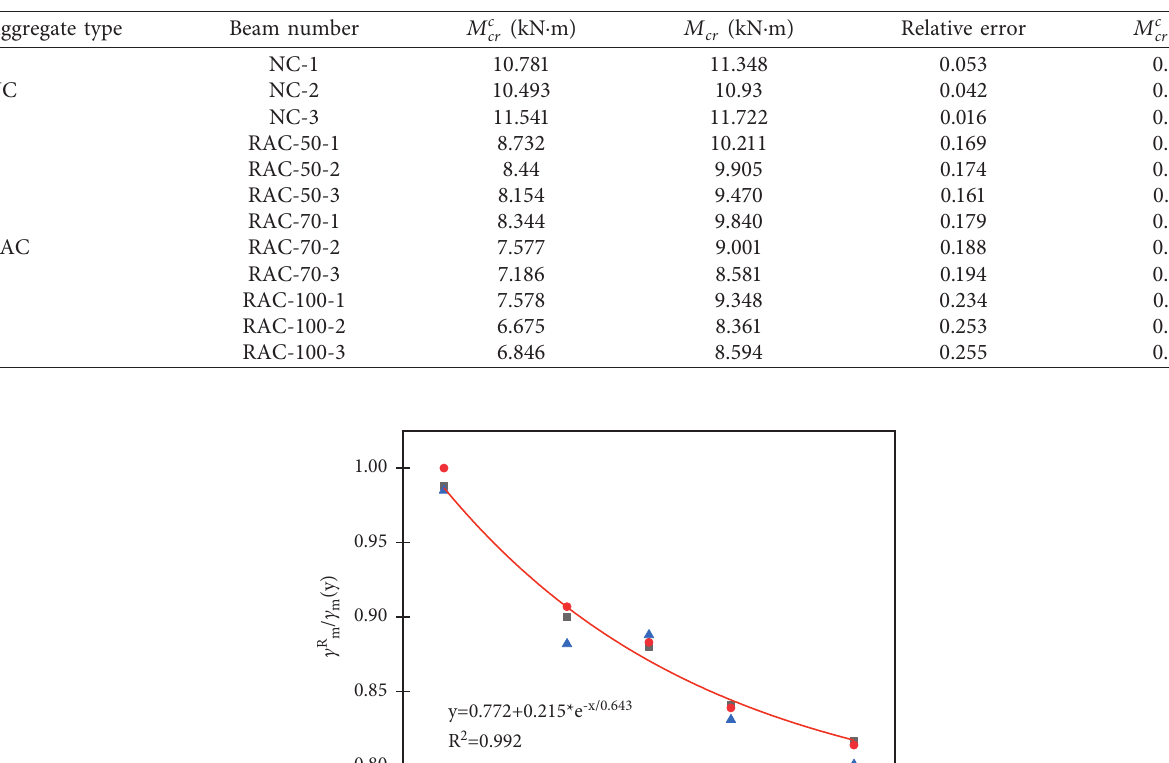
Table 9: Numerical simulation results of cracking moment.